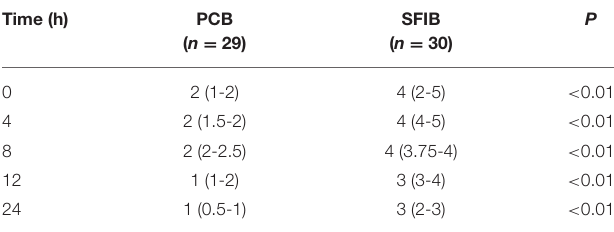
TABLE 2 | NRS pain score after extubation.